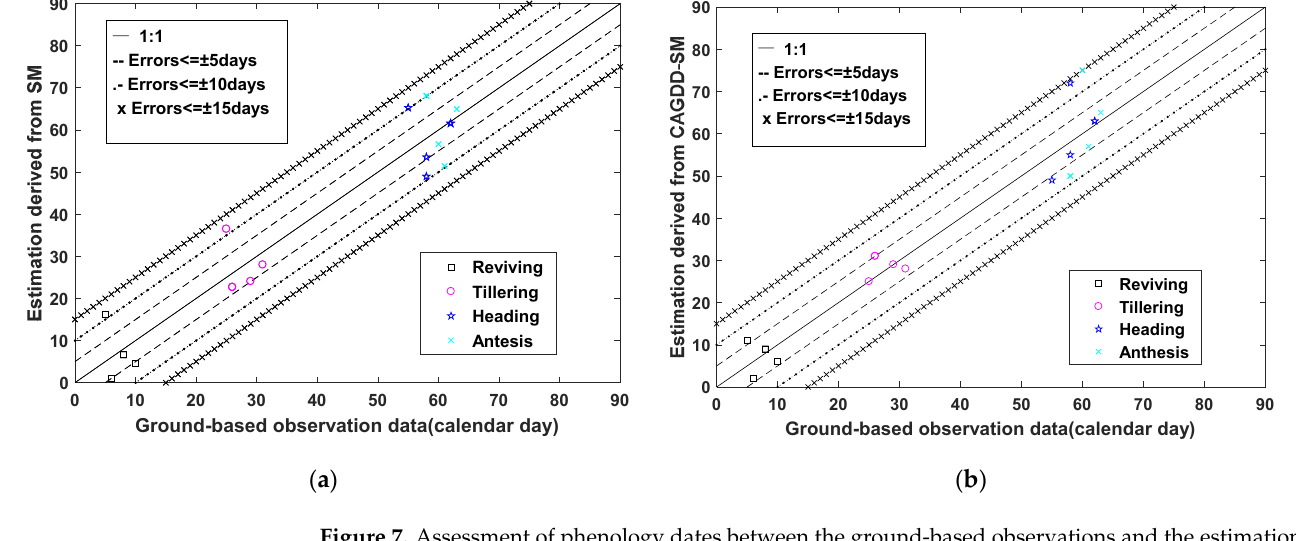
Figure 7. Assessment of phenology dates between the ground ‐ based observations and the estima ‐ tion derived from the CD ‐ SM and CAGDD ‐ SM. ( a ) CD ‐ SM. ( b ) CAGDD ‐ SM.